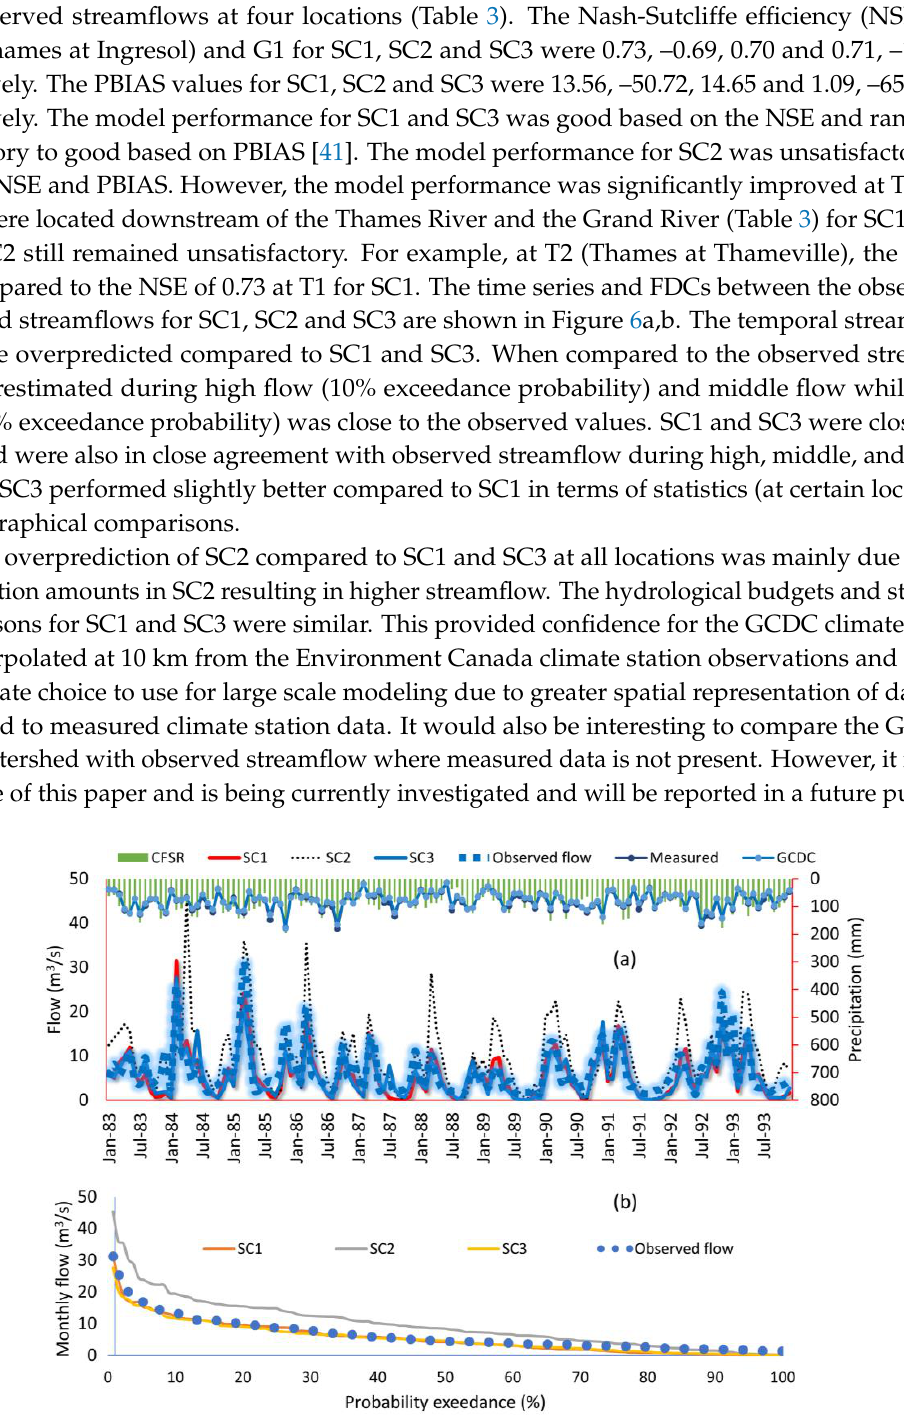
Figure 6. Comparison of simulated temporal streamflow scenarios (SC1, SC2 and SC3) observed at Ingresol station (T1). ( a ) Monthly time series plot for the time period of 1983 to 1993. ( b ) Flow duration curve (FDC) at station T1.